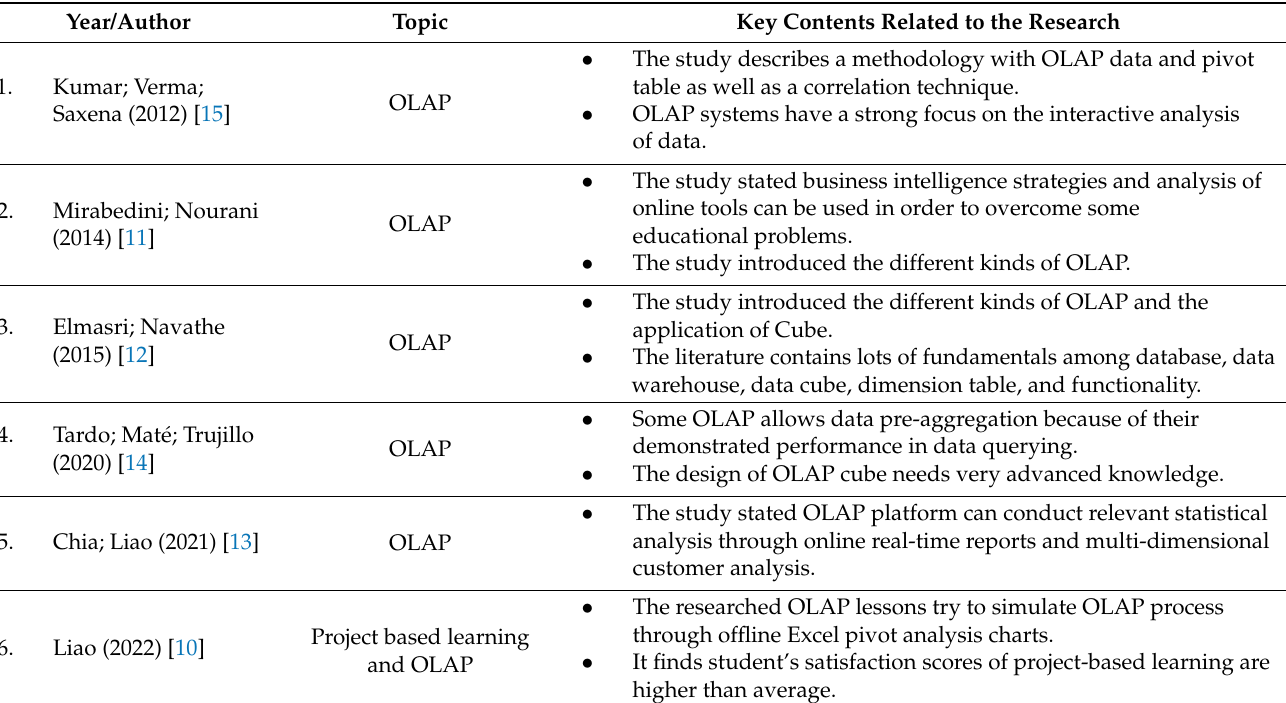
Table 2. Related literature of